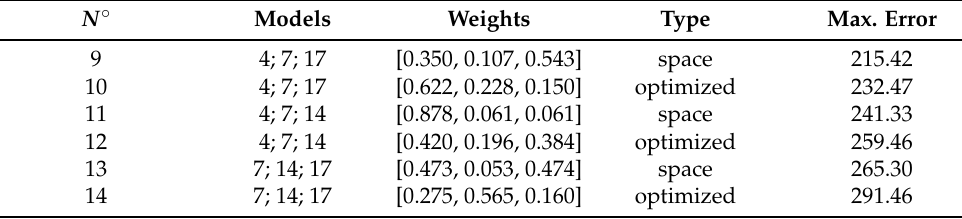
Table 16. Ensemble models tested using three single models and the maximum error obtained.